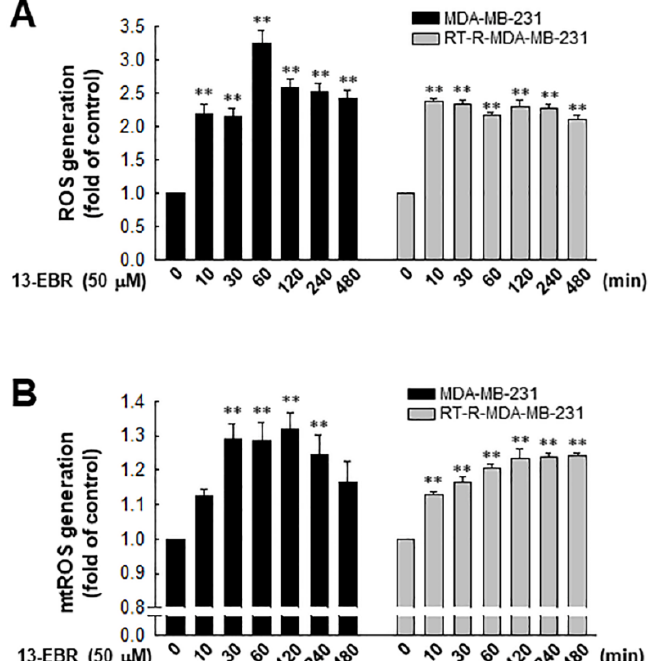
Figure 2. E ff ects of 13-EBR on the production of intracellular and mitochondrial reactive oxygen species (ROS) production in MDA-MB-231 and RT-R MDA-MB-231 cells. ( A , B ) Both cell lines were stimulated with 50 µ M 13-EBR for the indicated times, and then the intracellular ROS ( A ) and mitochondrial ROS ( B ) were measured by staining with 2’,7’-dichlorodihydrofluorescein diacetate (H 2 DCF-DA) and MitoSOX Red, respectively. The values represent the mean ± SEM of three independent experiments; ** p < 0.01 compared to the control of each cell line.